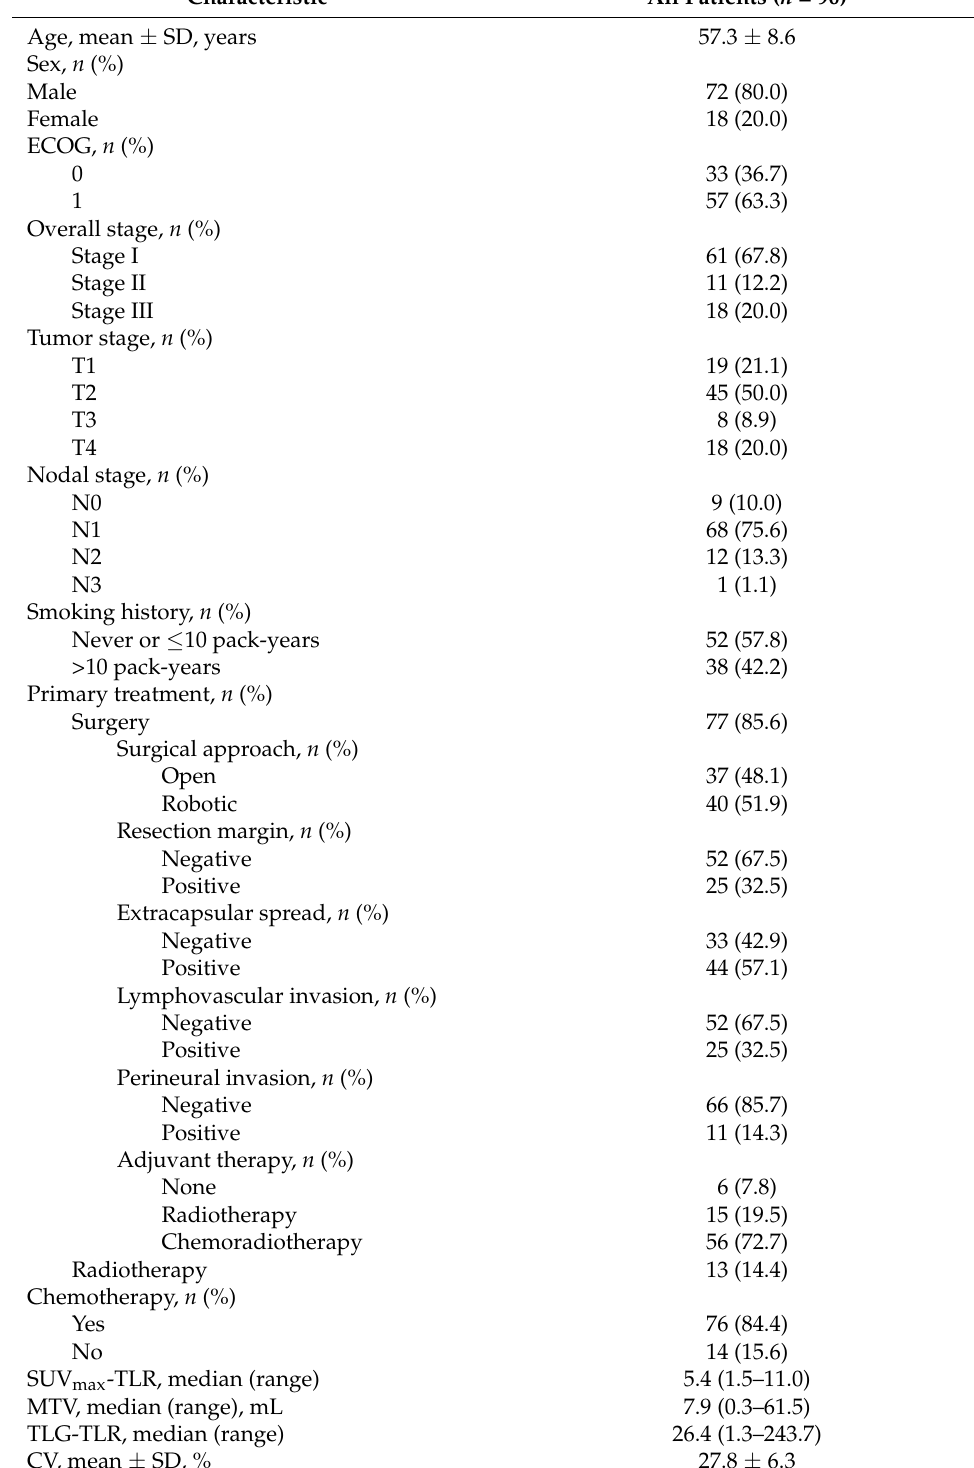
Table 1. Patient